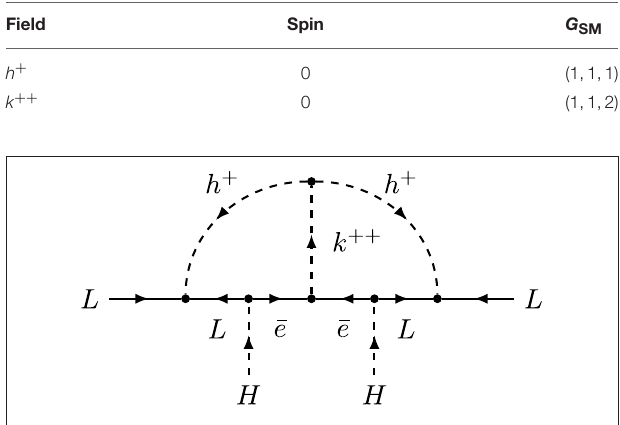
τµ ) can reach the percent level. BR( h BR( h → roughly two-orders of magnitude smaller than BR( h